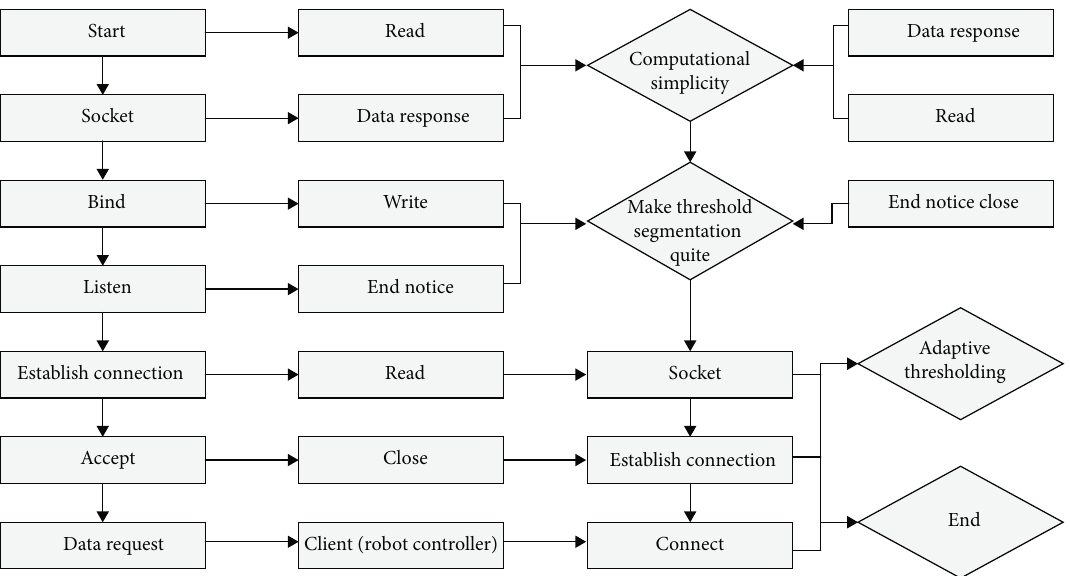
Figure 2: Communication fl ow between computer and controller.